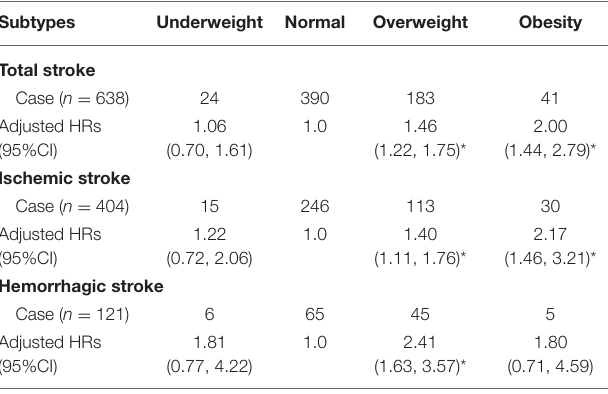
TABLE 3 | Association of BMI with total, ischemic, and hemorrhagic stroke using Cox regression analysis.